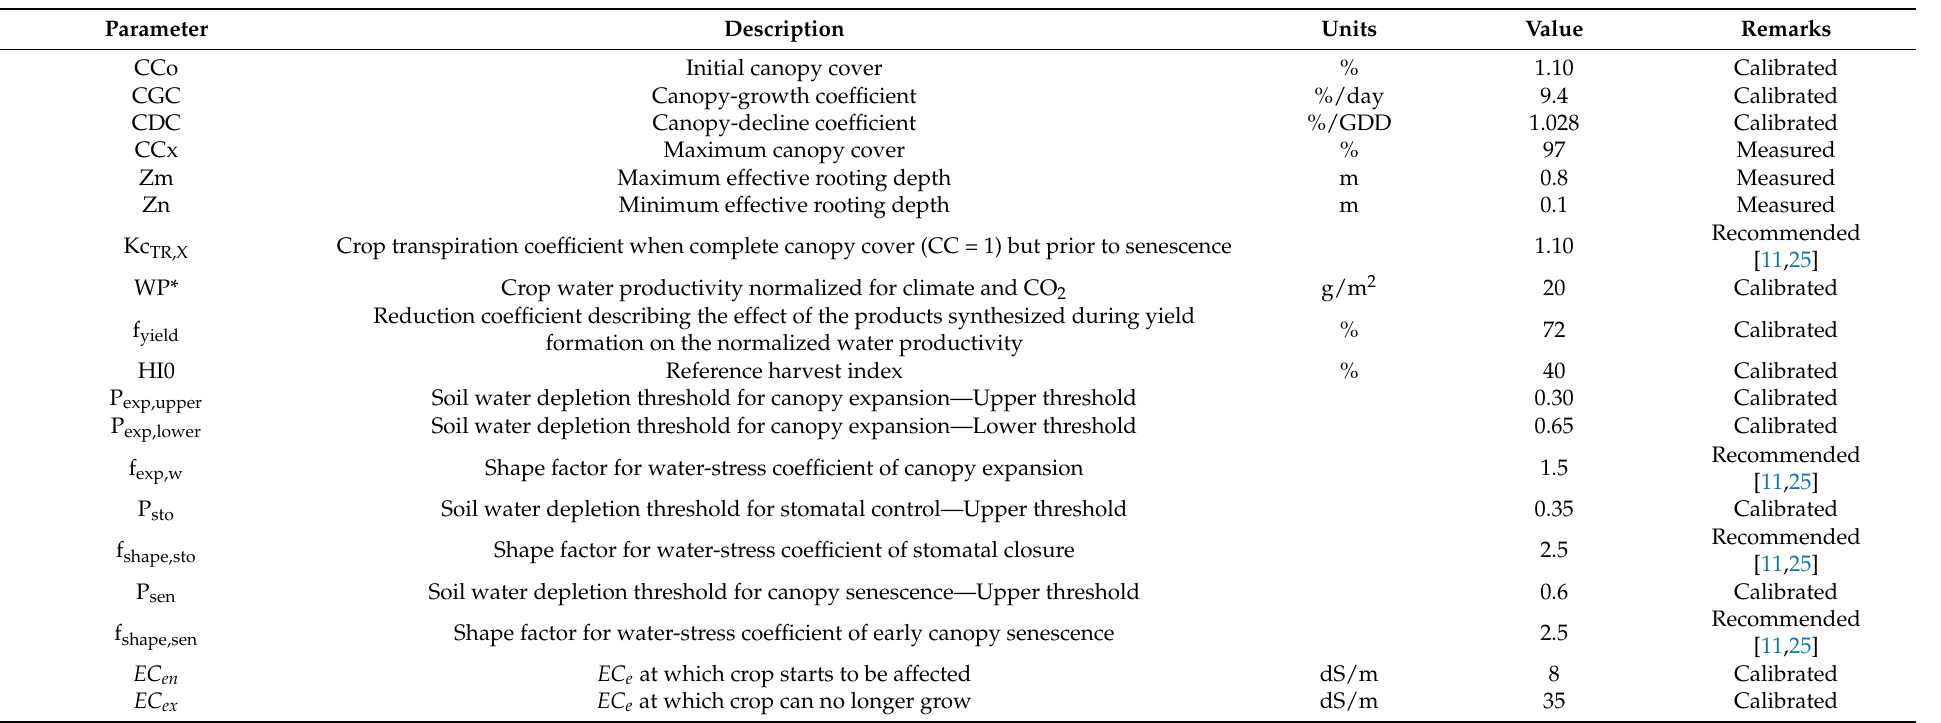
Table 2. Crop parameters in AquaCrop model for